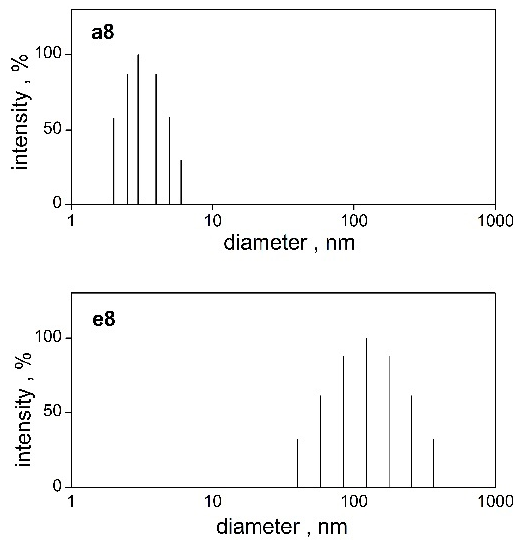
Molecules 2019 , 24 , x FOR PEER REVIEW 8 of 13 Figure 5. A : Micelle hydrodynamic diameter d of a(s) and e(s) gemini surfactants plotted as a function of surfactant spacer number s , at the surfactant concentration 6 × cmc . B: Zeta potential of a(s) and e(s) gemini micelles plotted as a function of surfactant spacer number s . Zeta potential of a(s) and e(s) gemini micelles was determined at the surfactant concentration 6 × cmc and 15 × cmc , respectively. Upon the mutual comparison of micelle diameters of a(s) and e(s) surfactants, a stronger aggregation tendency of diester molecules e(s) is observed, as documented by the larger particle size values and a steeper concentration increase of e(s) particle size (Figure 5A). The increase in the mean hydrodynamic particle diameter for long spacers of e7 and e8 diester surfactants may indicate the formation of intermicellar aggregates because their aggregation number is not large enough to form vesicles, as it is discussed in the previous section. In contrast, micelle size of diamide micelles a(s) lies